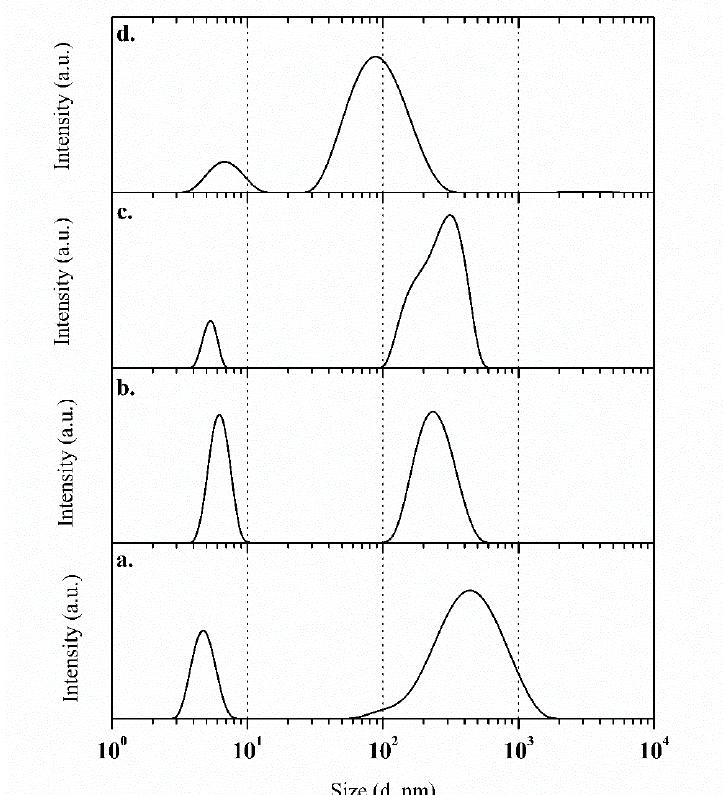
Figure 2. Dynamic light scattering analysis showing the size distribution of the different dispersion systems: ( a ) Sodium dodecyl sulfate (SDS), ( b ) SDS/3,4-ethylenedioxythiophene (EDOT), ( c ) SDS/EDOT/multi-walled carbon nanotube (MWCNT), and ( d ) SDS/EDOT/gold nanoparticle (AuNP) systems.